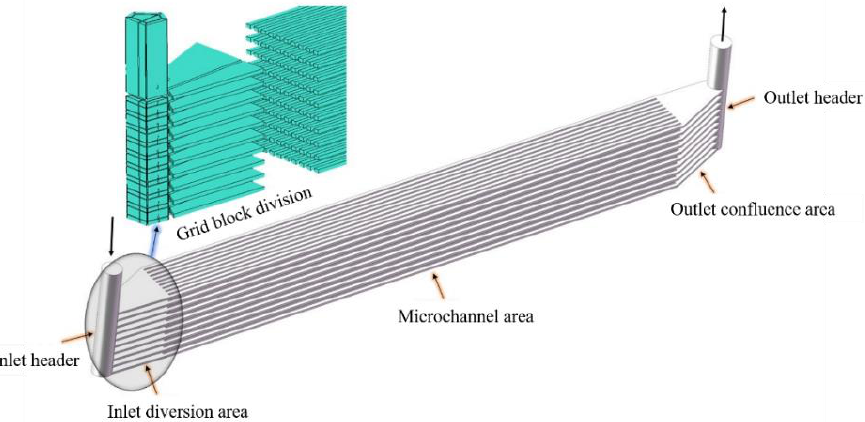
Figure 2. Single-side flow channel model and grid block division strategy of the straight-channel PCHE.